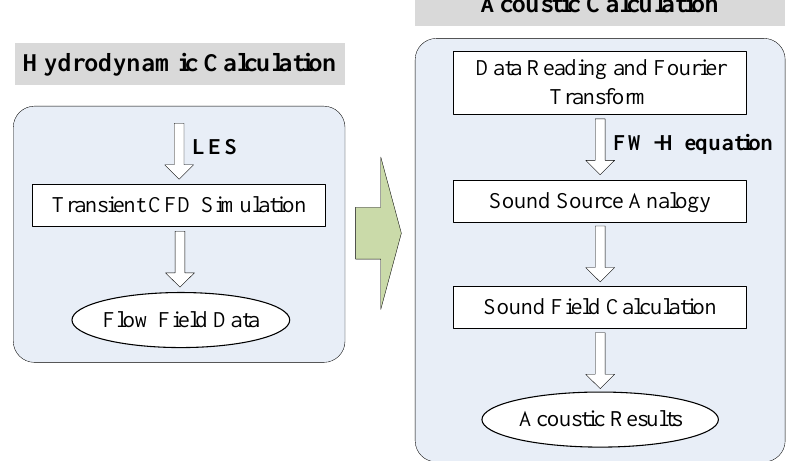
Figure 2. Flowchart of hydrodynamic noise calculation based on large eddy simulations (LES) and the Ffowcs Williams and Hawkings (FW-H) equation.